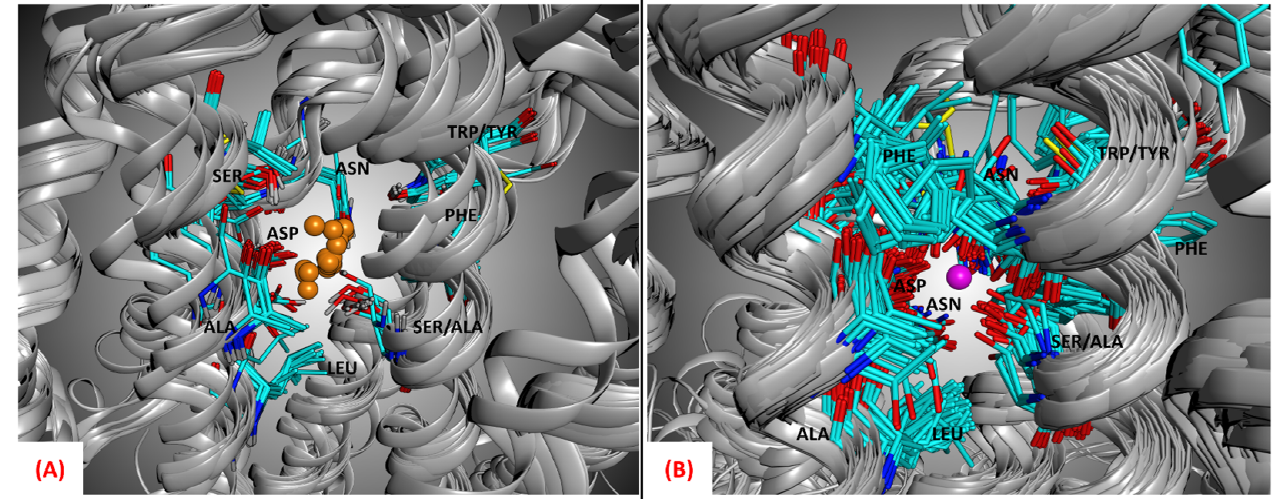
Figure 5. ( A ) Representation of the allosteric sodium binding site of all the 26 GPCR–antagonist complexes considered in this study which had the sodium ion present in their crystallographic structures. As depicted, the position of the sodium (the orange atoms in the image) is well conserved, as are the type and orientation of the side chains of the amino acids surrounding it, which help stabilize the alkaline ion. ( B ) Representation of the allosteric sodium binding site of all the 92 GPCR–antagonist complexes considered in this study in which the sodium ion is not present in the crystallographic structures. As can be seen, the potential position of the sodium (the purple atom in the image, which comes from the crystal upon which all proteins have been superposed, PDB code: 5IU4) is well conserved, as are the type and orientation of the side chains of the amino acids surrounding it, which help to stabilize the alkaline ion in its 7TM allosteric